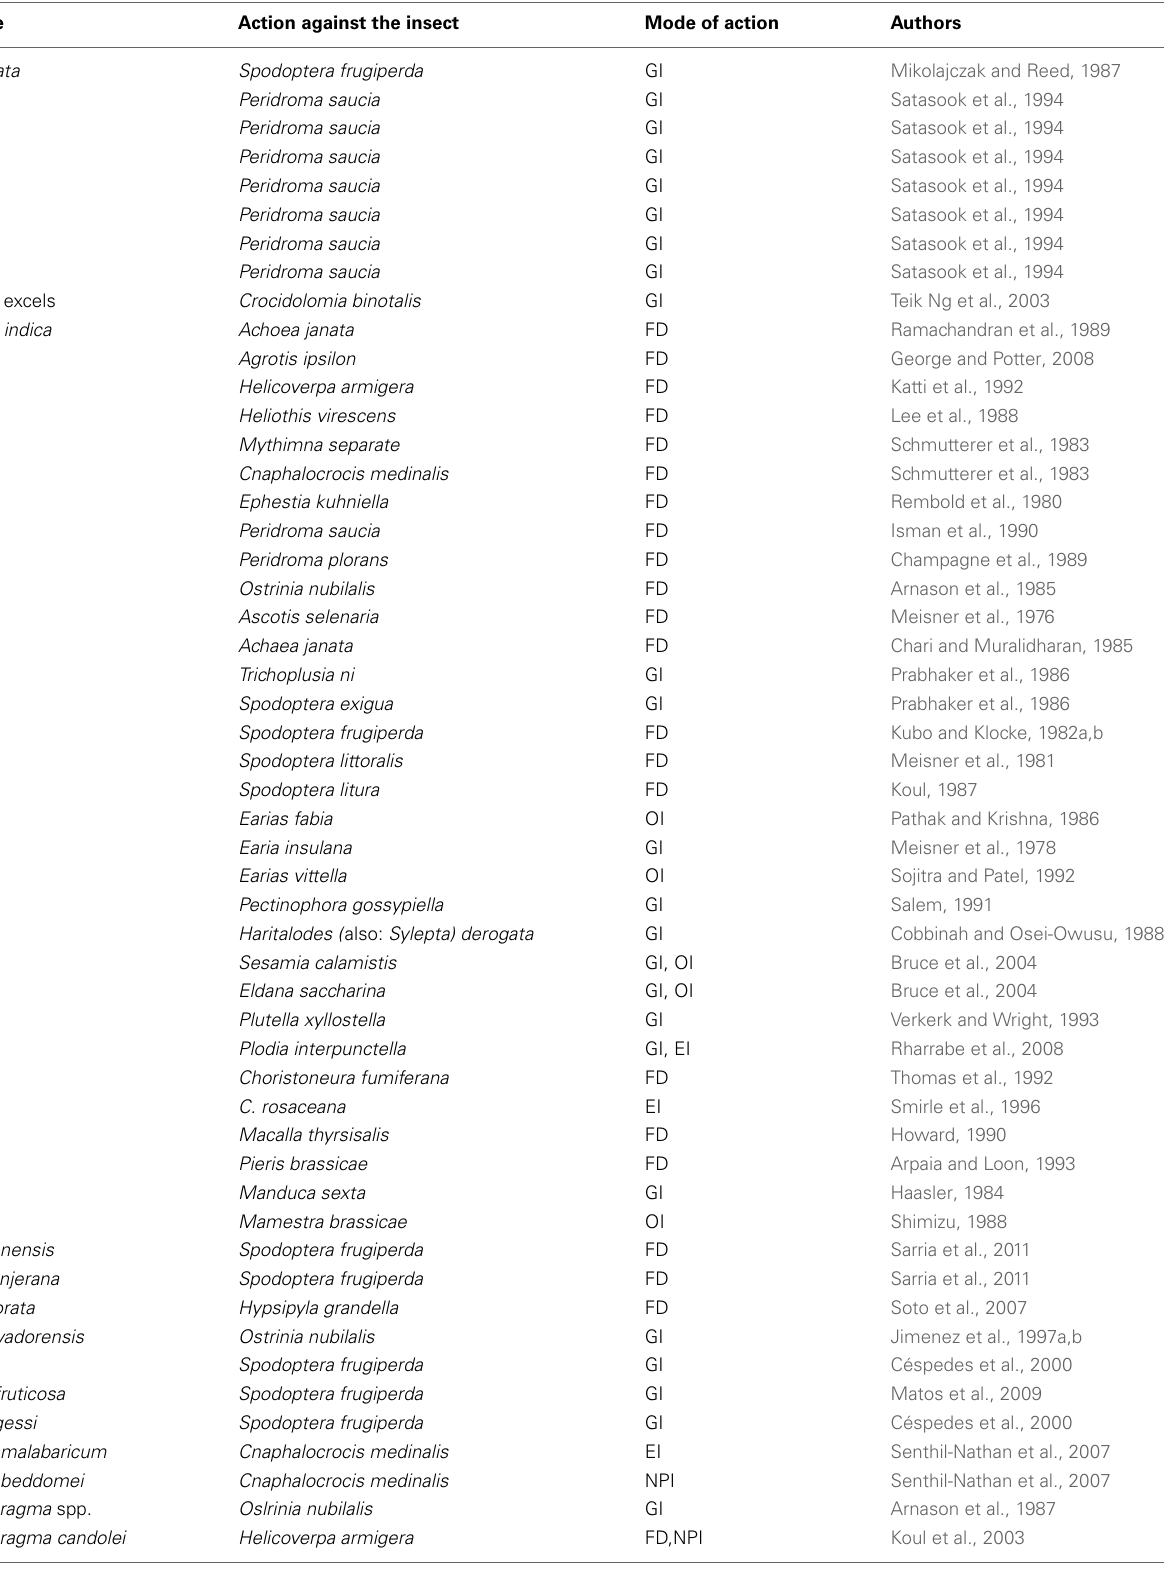
Table 1 | Biochemical effect of Meliaceae plants secondary metabolites against the Lepidopteran